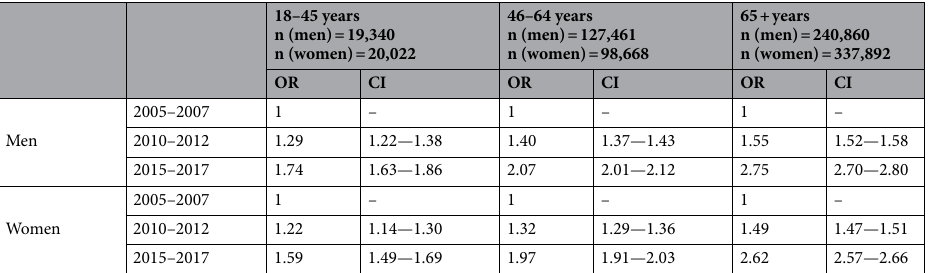
Table 3. Odds ratios and confidence intervals of the effect of time period on the number of comorbidities in T2D patients, stratified by age and gender, estimated by means of ordered logistic regression adjusting for within cluster variation. Adjusted for age (within each age group) and insurance duration. Outcome: number of comorbidities in four categories: 0, 1, 2 and 3 + . All odds ratios were significant at p < 0.001.